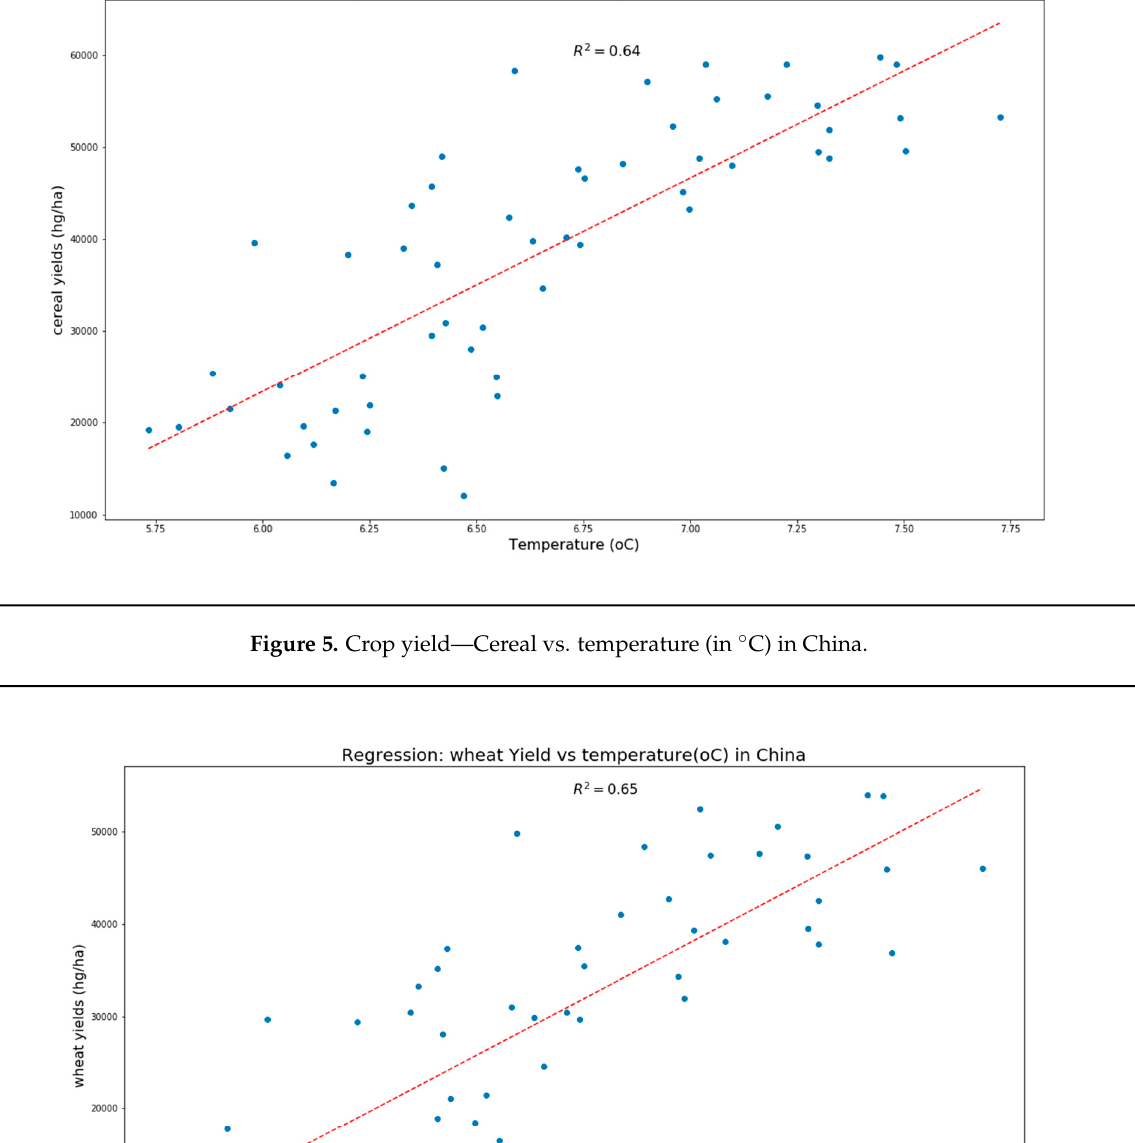
Figure 4. Crop yield—Rice vs. temperature (in °C) in China.